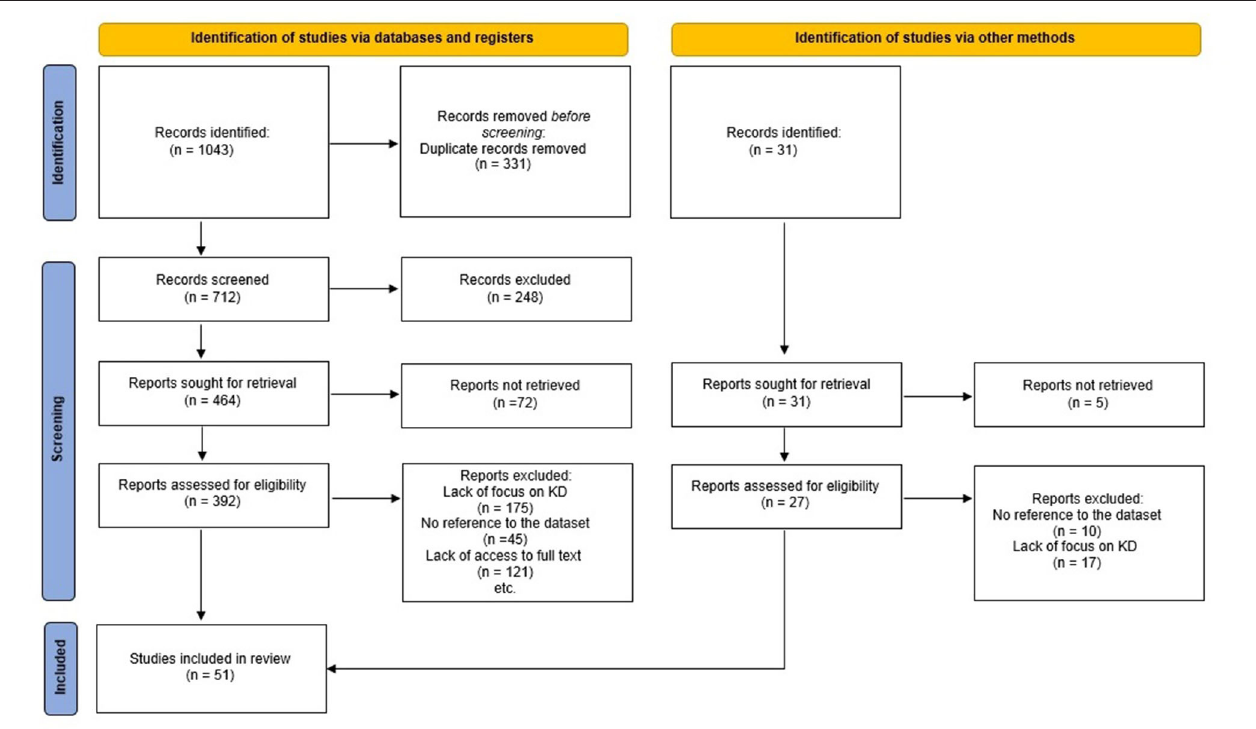
FIGURE 1 | PRISMA flow diagram for the systematic